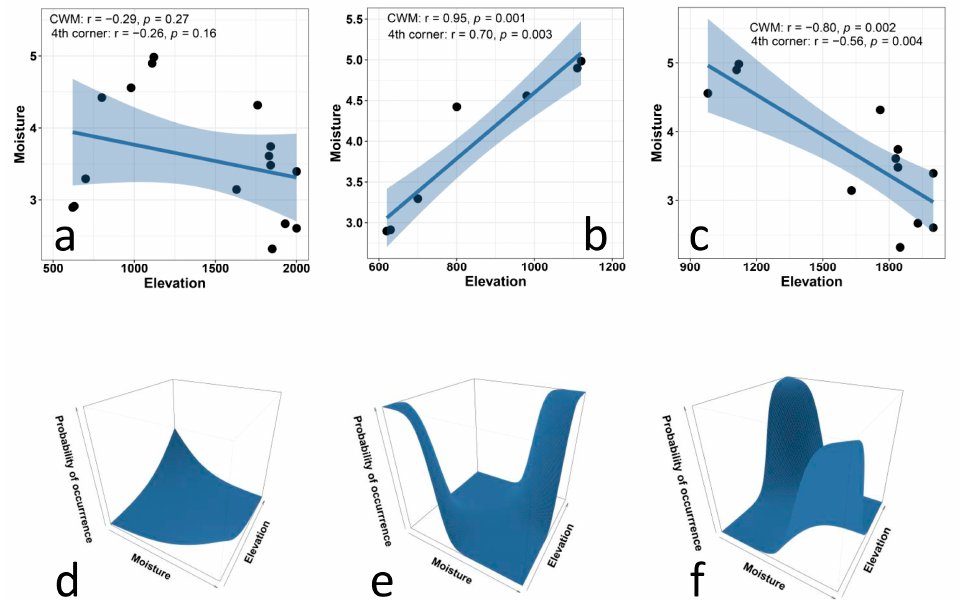
Figure 3. Relationship between Ellenberg indicator values for moisture and elevation in plant communities along an elevational gradient in Central Italy. The upper panels ( a – d ) present CWM regression models and their statistical corrections using fourth-corner analysis for the entire gradient ( a ), for the lower subgradient ( b ), and for the upper subgradient ( c ). The lower panels ( d – f ) illustrate the results of multi-level models for the entire gradient ( d , trait × environment interaction p < 0.01, marginal R 2 = 0.02), for the lower subgradient ( e , trait × environment interaction p < 0.001, marginal R 2 = 0.21), and for the upper subgradient ( f , trait × environment interaction p < 0.001, marginal R 2 = 0.13).